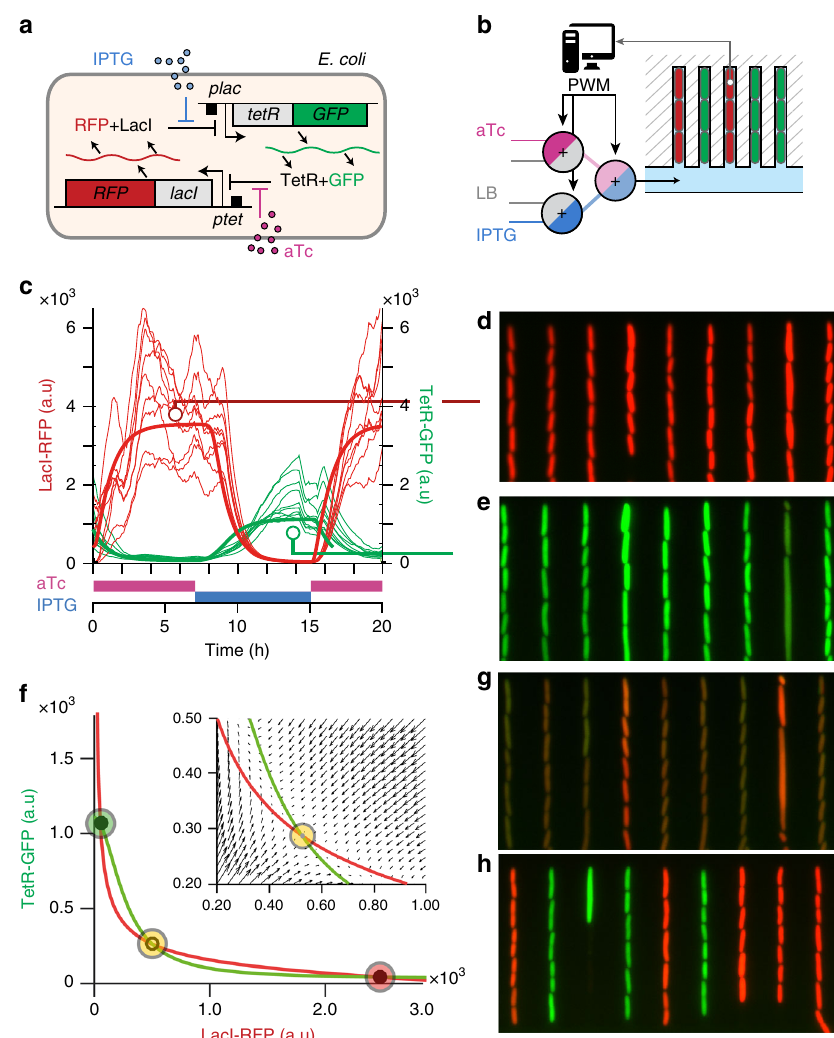
Fig. 1 Construction and characterization of a genetic toggle switch that displays bistable behavior. a The genetic toggle switch is composed of two mutually repressing branches, the strength of each can be tuned by addition of two chemicals (aTc or IPTG) to the cellular environment. The levels of the two repressors (LacI and TetR) can be observed using two fl uorescent reporters (mKate2 and mEGFP). b E. coli cells are forced to grow in parallel lines in a micro fl uidic device to facilitate cell segmentation and tracking. Three valves used in pulse-width-modulation (PWM) allow the modulation of the concentrations of aTc and IPTG in real-time (Supplementary Fig. 2). c To calibrate a model of the toggle switch (see “ Methods ” section), the single-cell responses of red (LacI) and green (TetR) fl uorescence were measured as a function of step changes in aTc and IPTG concentrations ( n = 9, see also Supplementary Fig. 3). Model outputs for averaged LacI and TetR levels are represented by the thick red and green lines. As expected for a toggle switch circuit, in presence of excess aTc, all cells are in a red-dominant (LacI) state ( d ), while all cells switch to a green-dominant (TetR) state in the presence of excess IPTG ( e ). f LacI (red) and TetR (green) nullclines of the fi tted model under reference conditions (aTc = 20 ng ml − 1 ; IPTG = 0.25 mM). The state space presents two stable equilibrium points (red and green circles) and one unstable equilibrium point (yellow circle). The inset shows the vector fi eld close to the unstable point. Stability analysis of the model indicated that for a large region of the state space, in which protein levels are comparable, no static combinations of aTc and IPTG concentrations could be used to maintain a cell in that region (see Supplementary Fig. 6). Experimentally, while cells transiently expressing both green and red fl uorescence could be observed g , the cells eventually committed to one of the two stable states h as expected for a bistable toggle switch, illustrating that dynamic control is required to maintain cells away from their two stable